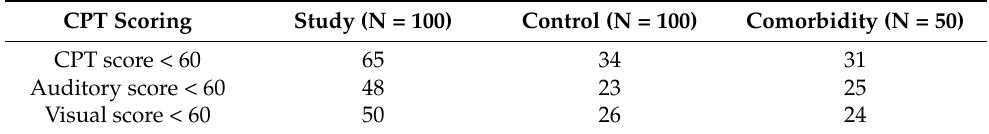
Visual score < 60 50 24 Participant CPT scores were dichotomized into two categories (scores below 60 and scores equal to or above 60) and grouped according to their control or comorbidity status.